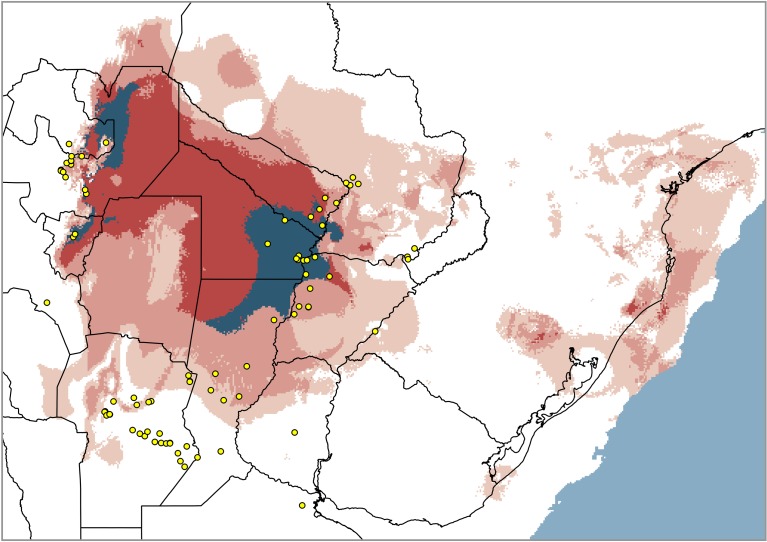
Overlay of the binary predictions of Discocyrtus dilatatus for three LGM simulations (CCSM, MIROC and MPI).The overlap area of three, two or one models is displayed in decreasing intensities of red. Within the three-GCM-overlap, the ‘stable area since -21k’ (i.e., the grid-cells shared by all current, -6k and LGM models) is identified with blue.